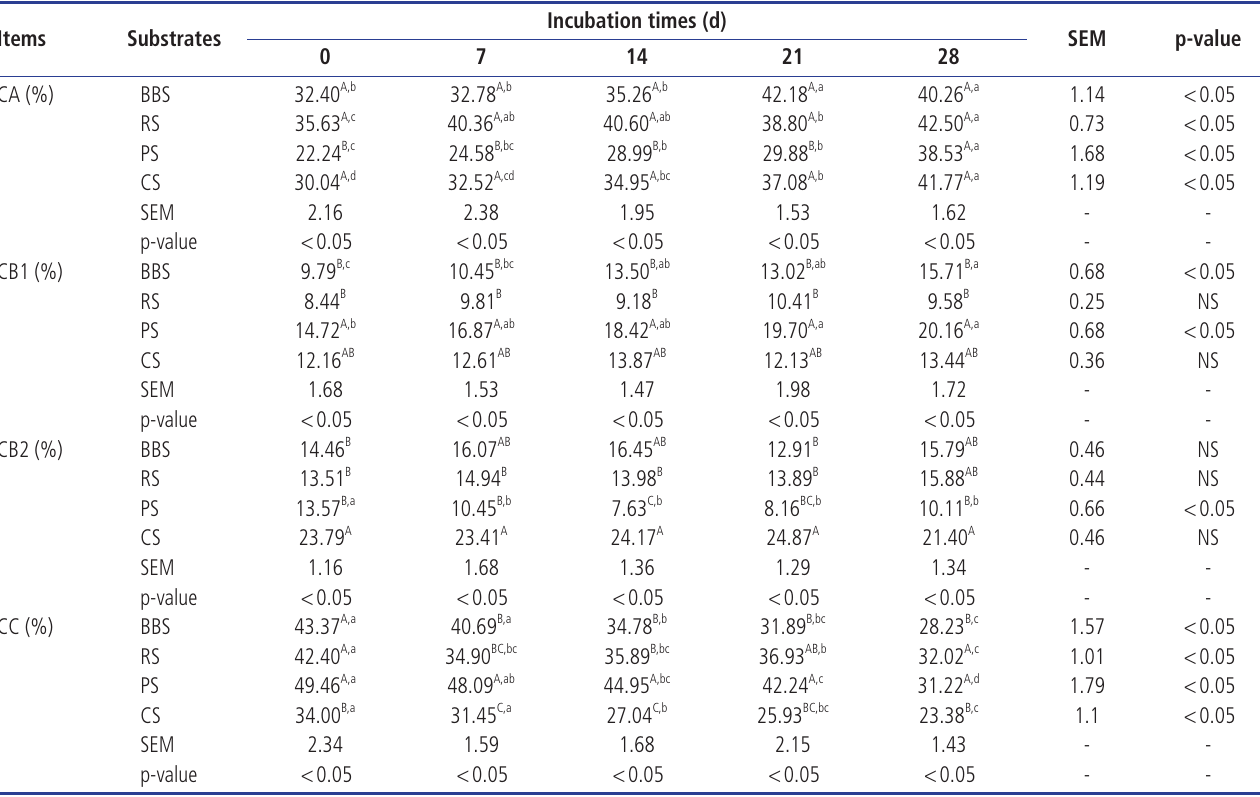
Table 4. The CNCPS carbohydrate fractions (DM base) of broad bean stalks, rape straw, paddy straw and corn stalk degraded by Pleurotus ostreatus for different time